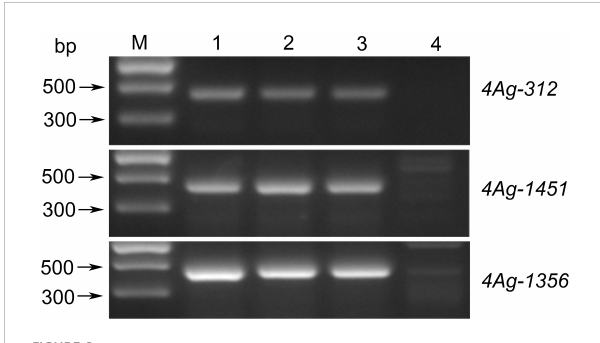
FIGURE 8 Ampli fi ed results of three speci fi c markers of WTT146. M: Marker II; 1: Blue 58; 2: WTT146; 3: J146; 4: Jimai 22.